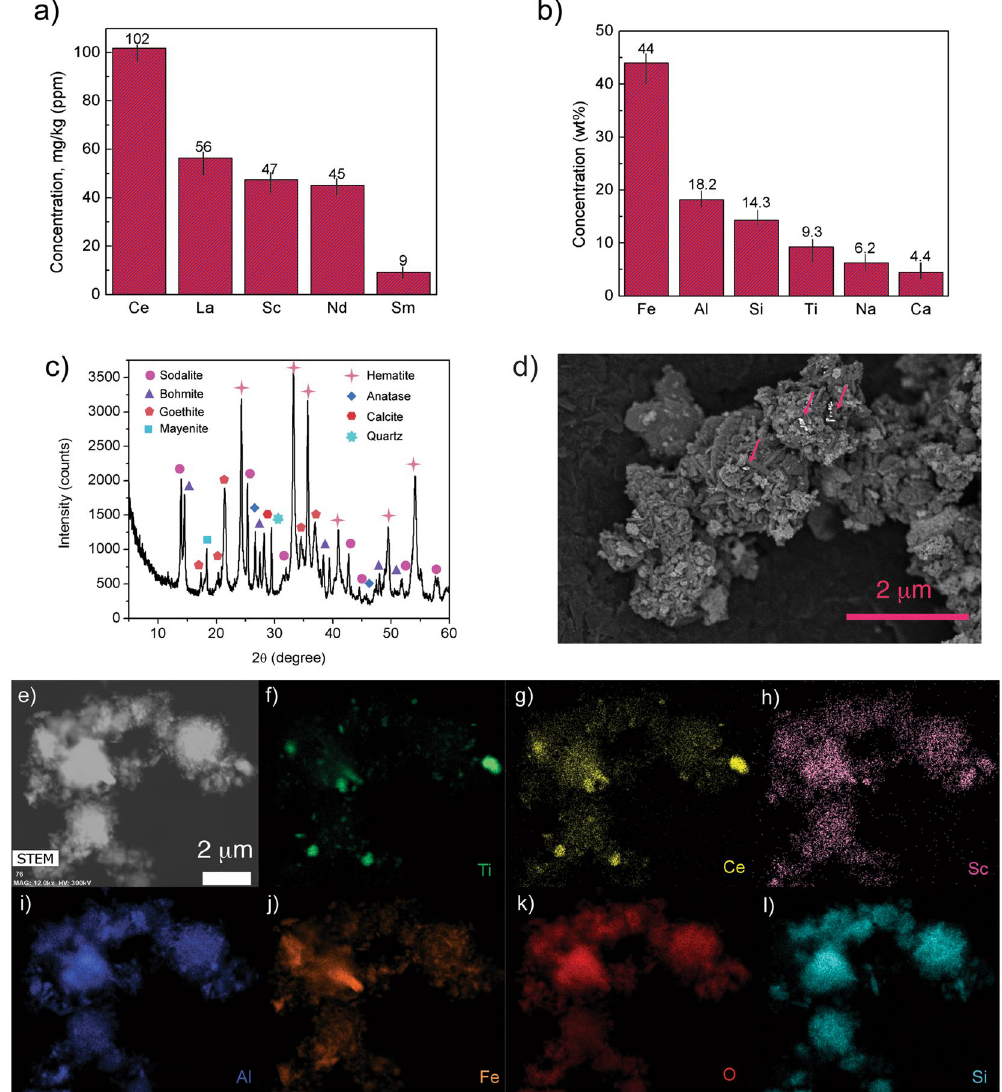
Figure 1. Bauxite residue characterization results. ( a ) Aqua regia digestion - ICP-OES results indicating REEs composition. ( b ) XRF elemental composition. Error bars represent the standard error of the mean for ten replicates ( c ) X-ray diffractogram. ( d ) BSE image of the bauxite residue particle; bright spots are the high atomic number REEs. ( e – l ) STEM image and EDS elemental mapping of the bauxite residue